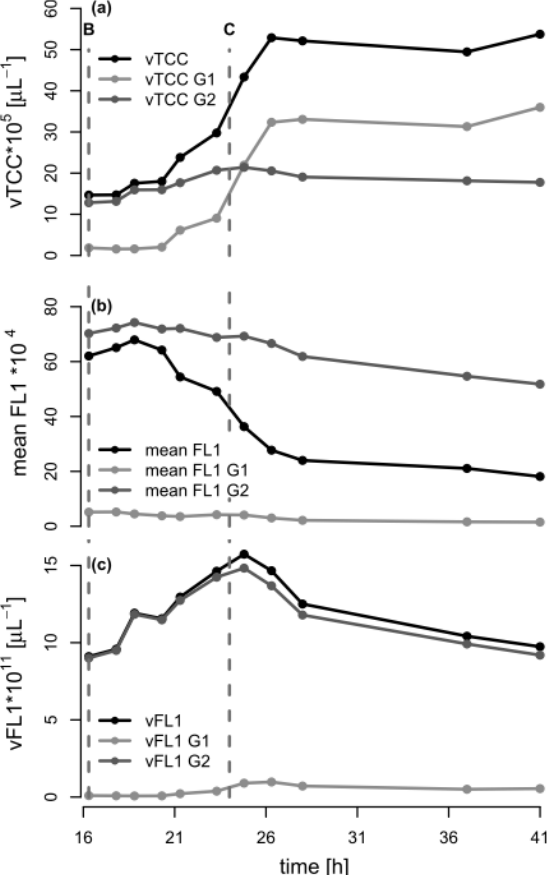
Figure 4. Analysis of the flow cytometry (FCM) data during the depolymerization phase of the fed-batch experiment with P. putida KT2440 on octanoic acid (C8). The data from the FCM analysis during the second phase of fermentation ( t = 16.3–41 h) are shown for the total population, as well as for the populations of gates G1 and G2 (low/no PHA and high PHA content, respectively). The dashed lines B and C indicate the time points when the C8 feeding was stopped and the ammonium pulse added (16.3 h), and when C8 was completely consumed ( t = 24 h), respectively. ( a ) Volumetric total cell count (vTCC); ( b ) Mean FL1 fluorescence (PHA content); ( c ) Volumetric fluorescence (vFL1, computed by multiplying vTCC by FL1).